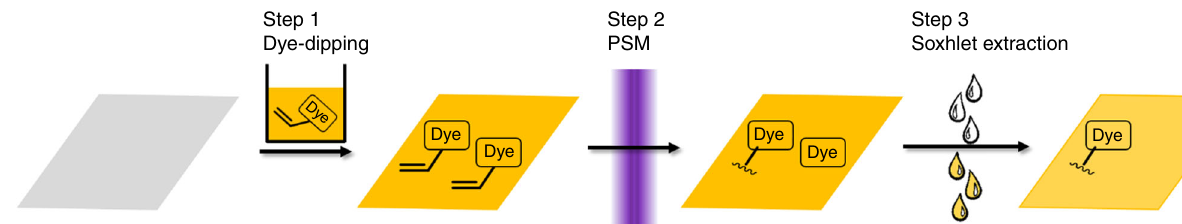
Fig. 2 Schematic representation of the plasma dye coating procedure